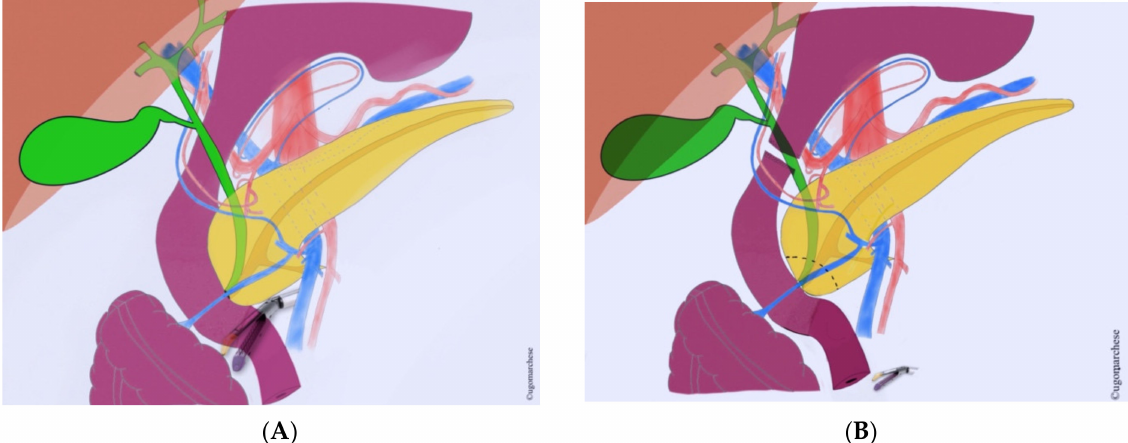
Figure 6. Duodenal sparing resection: ( A ) Partial distal duodenectomy. ( B ) Total duodenectomy with ampullectomy.